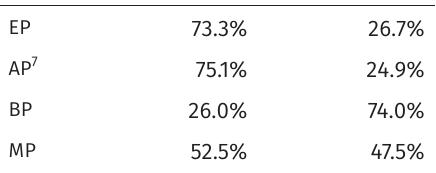
Table 4: SPE in European, Angolan, Brazilian, and Mozambican Portuguese. Variety Null subjects Overt